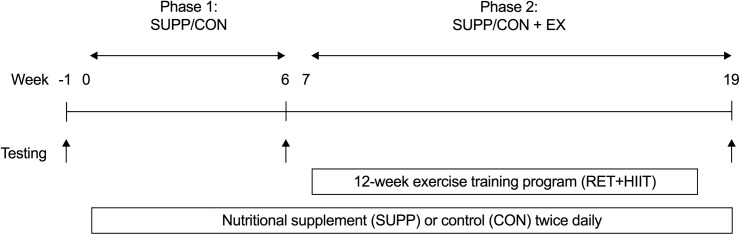
Schematic of study design.Participants consumed either a multi-ingredient protein-based nutritional supplement (SUPP) or control (CON) drink for 20 weeks total (from weeks 0–19, inclusive), and completed a 12 week exercise training program (RET twice per week and HIIT once per week) between weeks 7–18. Testing occurred at weeks -1 (baseline), 6, and 19, and included the following assessments: isotonic strength (1RM), aerobic fitness (VO2peak), physical function, body composition (DXA), and a 75g OGTT. Phase 1: SUPP/CON took place between weeks 0–6, and Phase 2: SUPP/CON + EX took place between weeks 7–19. 1RM, one repetition maximum; DXA, dual-energy x-ray absorptiometry; HIIT, high-intensity interval training; OGTT, oral glucose tolerance test; RET, resistance exercise training; VO2peak, peak oxygen uptake.